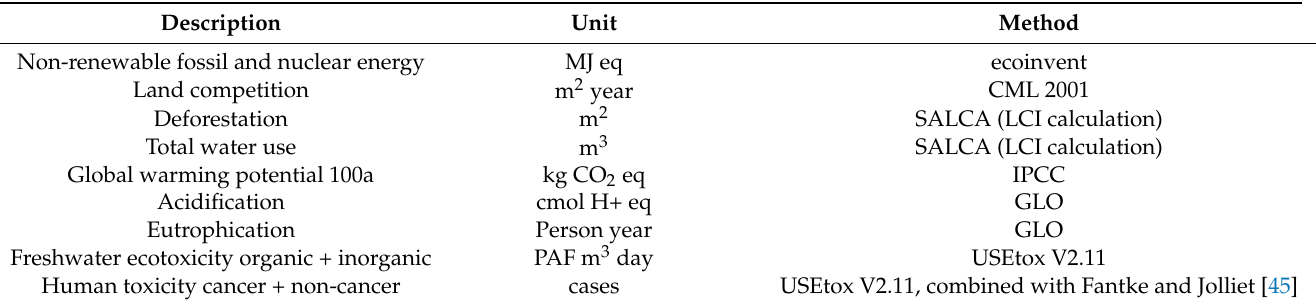
Table 1. Used mid-point indicators in the impact